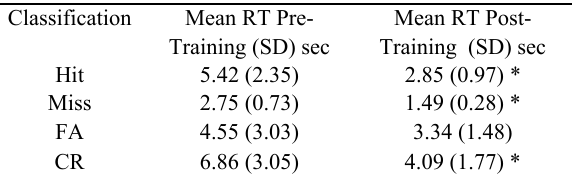
Mean reaction times in seconds and standard deviations (SD) for the four classifications from all users. The hit, miss, and CR reaction times were significantly different following training. * p ≤ 0.001.